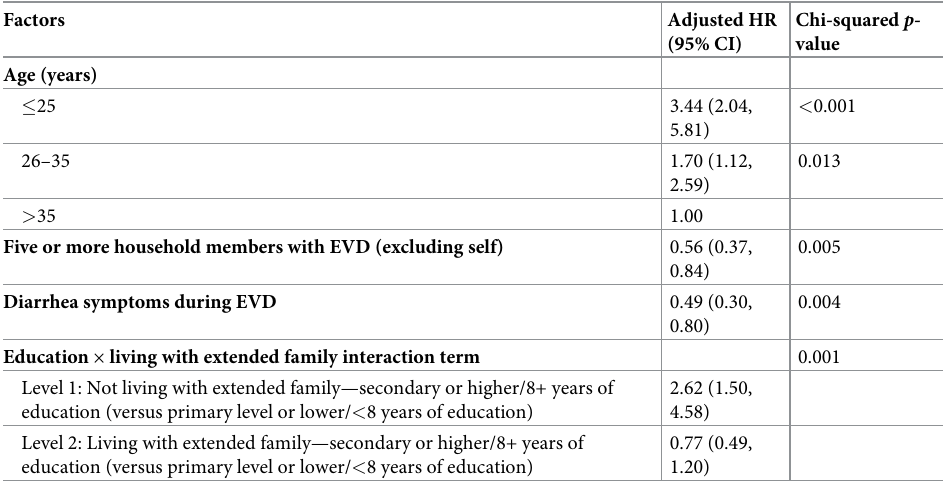
Table 3. Multivariate model with living with extended family × education interaction term.